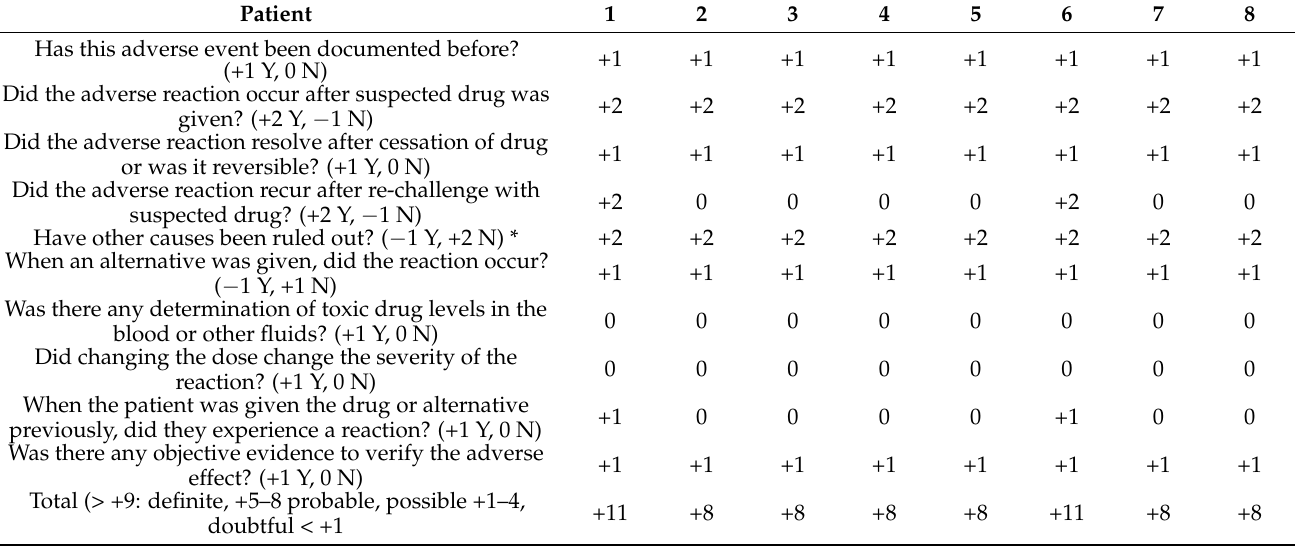
Table 4. The Naranjo probability scale to determine the likelihood of causation of dapsone and anemia. Two patients scored definite causal relationship while six patients scored probable causal relationship. Adapted from Naranjo et al. [15].